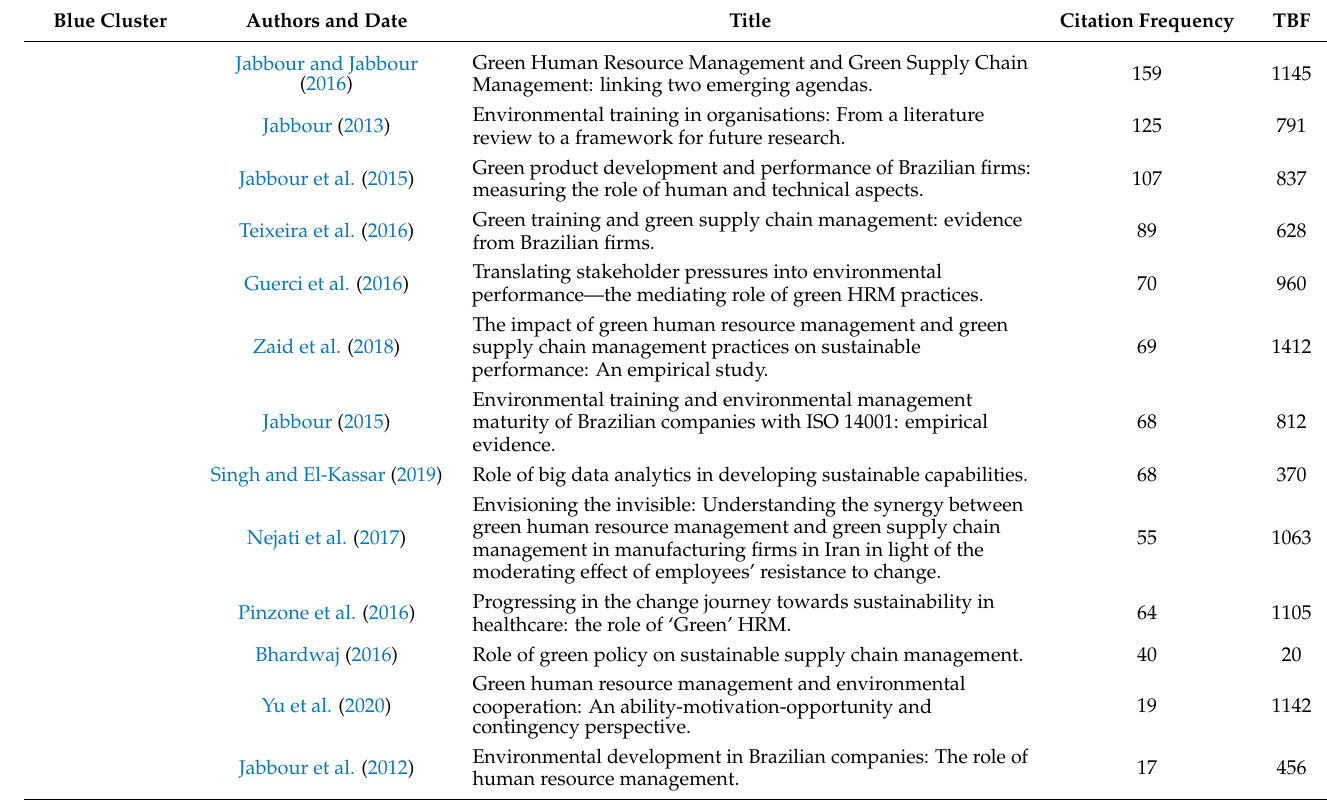
Table A2. Publications from the bibliographic coupling analysis—blue